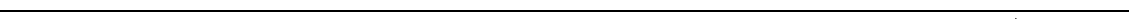
Fig. 3 The metabolic bene fi ts of mural Pparg overexpression depend on adiponectin. a Adiponectin -de fi cient ( Adiponectin − / − ) mice and Adiponectin − / − ; Pdgfrb rtTA ; TRE - Pparg2 ( Adiponectin − / − ; Mural- Pparg TG ) mice were fed a standard chow diet until 6 weeks of age before being switched to dox-containing HFD. Body weights were measured weekly following the onset of HFD feeding. n = 6 per genotype. Data points represent mean + s.e.m. b Fat mass and lean mass (normalized to body weight) of Adiponectin − / − and Adiponectin − / − ; Mural- Pparg TG mice after 16 weeks of dox-HFD feeding. n = 6 per genotype. Bars represent mean + s.e.m. c Average adipocyte size in indicated fat depots from control and Mural- Pparg TG mice after 16 weeks of dox-diet feeding. Bars represent mean + s.e.m. d Fat pad weight (normalized to body weight) of Adiponectin − / − and Adiponectin − / − ; Mural- Pparg TG mice after 16 weeks of dox- HFD feeding. * denotes p < 0.05 from Student ’ s t -test. n = 6 per genotype. Bars represent mean + s.e.m. e – l Representative immuno fl uorescence staining of Perilipin (green) and Mac-2 (red) in e , f gonadal, g , h perirenal WAT, i , j inguinal WAT, and k – l mesenteric WAT paraf fi n sections obtained from Adiponectin − / − and Adiponectin − / − ; Mural- Pparg TG mice after 16 weeks of dox-HFD feeding. Scale bar, 200 μ m. m Numbers of crown-like structures (Mac- 2 positive) in the indicated depots from Adiponectin − / − and Adiponectin − / − ; Mural- Pparg TG mice after 16 weeks of dox-HFD feeding. * denotes p < 0.05 from Welch ’ s t -test. n = 24 randomly chosen ×10 magni fi cation fi elds from six individual animals. Bars represent mean + s.e.m. n Six-hour fasting serum insulin levels in Adiponectin − / − and Adiponectin − / − ; Mural- Pparg TG mice after 16 weeks of dox-diet feeding. n.s. denotes not statistically signi fi cant. n = 6 per genotype. Bars represent mean + s.e.m. o Glucose tolerance tests of Adiponectin − / − and Adiponectin − / − ; Mural- Pparg TG mice after 16 weeks of dox- diet feeding. n = 6 per genotype. Data points represent mean + s.e.m. p Glucose area under the curve measurements during glucose tolerance test from mice of indicated genotypes after 16 weeks of dox-diet feeding. Two-way ANOVA, * p < 0.05; n.s. denotes not statistically signi fi cant; Adiponectin + / + , n = 8; Adiponectin + / + ; Mural- Pparg TG , n = 9; Adiponectin − / − , n = 6; Adiponectin − / − ; Mural- Pparg TG , n = 6. Bars represent mean + s.e.m. q Insulin tolerance test of Adiponectin − / − and Adiponectin − / − ; Mural- Pparg TG mice after 16 weeks of dox-diet feeding. n = 6 per genotype. Data points represent mean + s.e.m. r Glucose area under the curve measurements during insulin tolerance test from mice of indicated genotypes after 16 weeks of dox-diet feeding. Two-way ANOVA, * p <0.05; n.s. denotes not statistically signi fi cant; Adiponectin + / + , n = 8; Adiponectin + / + ; Mural- Pparg TG , n = 9; Adiponectin − / − , n = 6; Adiponectin − / − ; Mural- Pparg TG , n = 6. Bars represent mean +